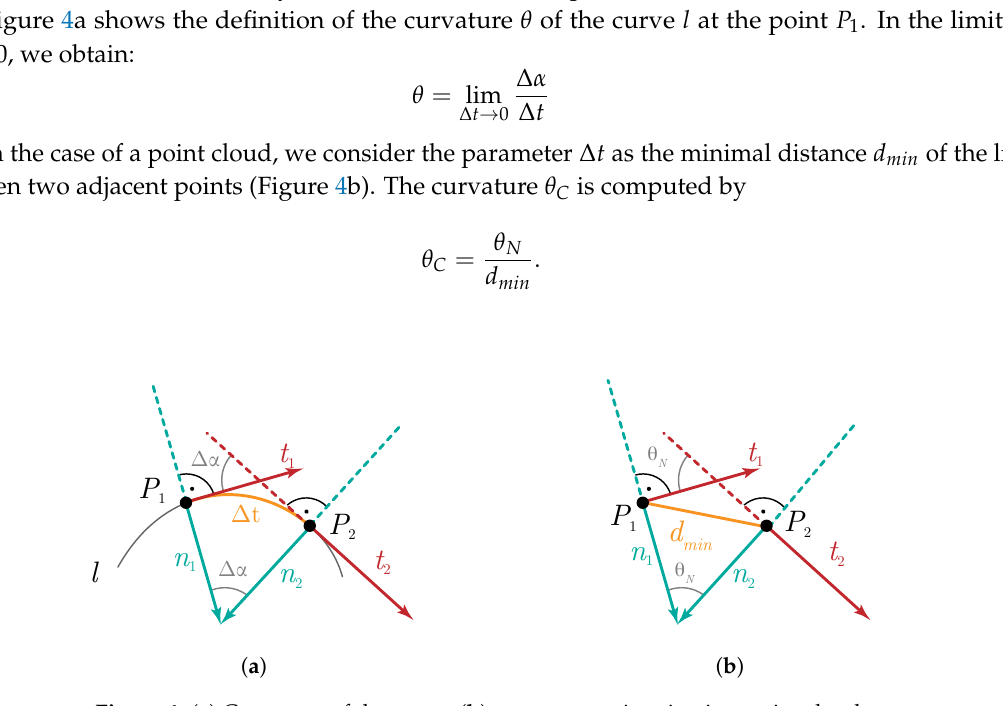
Figure 4. ( a ) Curvature of the curve, ( b ) curvature estimation in a point